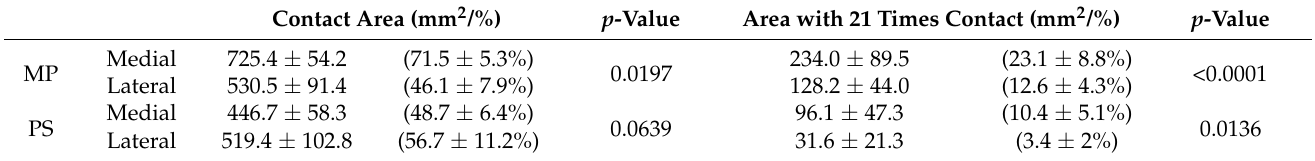
Figure 5. The heatmap of cumulative times of contact for (( A ), n = 12) PS-TKA and (( B ), n = 16) MP-TKA during lunge were presented on the right standard size of tibial insertions. The range of lunge was divided into 21 instantaneous moments with 5 ◦ flexion intervals from 0 ◦ to 100 ◦ . The dark blue area on tibial insertion showed a few contact times, while red highlighted areas with high contact times. The length and width of insertion were normalized to − 0.5–0.5 ( − 50%–50%). MP: Medial-pivot. PS: Posterior-stabilized. TKA: Total knee arthroplasty. Table 4. The contact area and the 21 times contact area of PS and MP TKA patients were